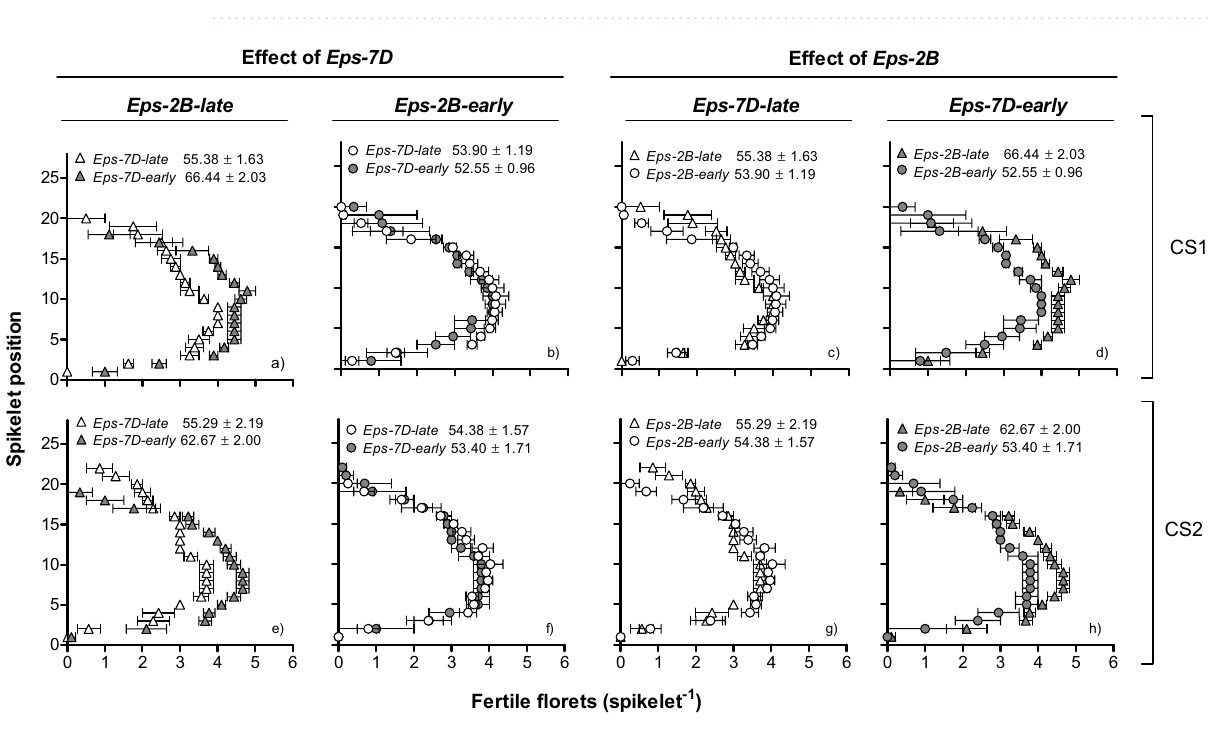
Figure 9. Number of living floret primordia per spikelet (average across apical, central and basal spikelets) and thermal time from sowing as affected by Eps-7D (left panels: a , b , e , f ) and Eps-2B genes (right panels: c , d , g , h ) on backgrounds contrasting in the allelic form of the other Eps gene (left and right panels within each Eps gene) in first (top panels: a – d ) and second (bottom panels: e – h ) cropping seasons. Eps-7D-late and - early (open and closed symbols, respectively) and Eps-2B-late and - early allele (triangle and circles, respectively). Bars are the standard errors among spikelet position.